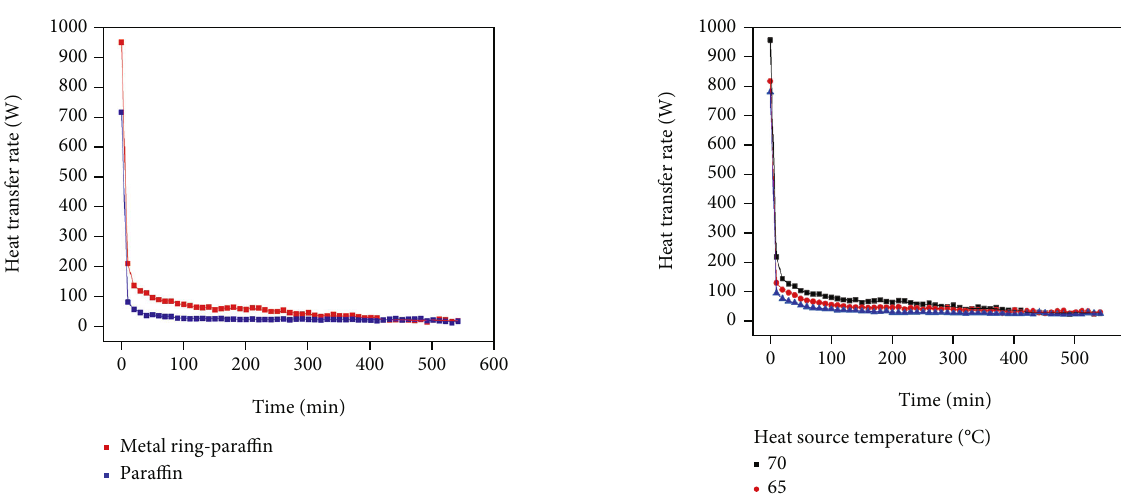
Figure 13: Heat transmission rates for various fi ller materials in heat storage devices. Figure